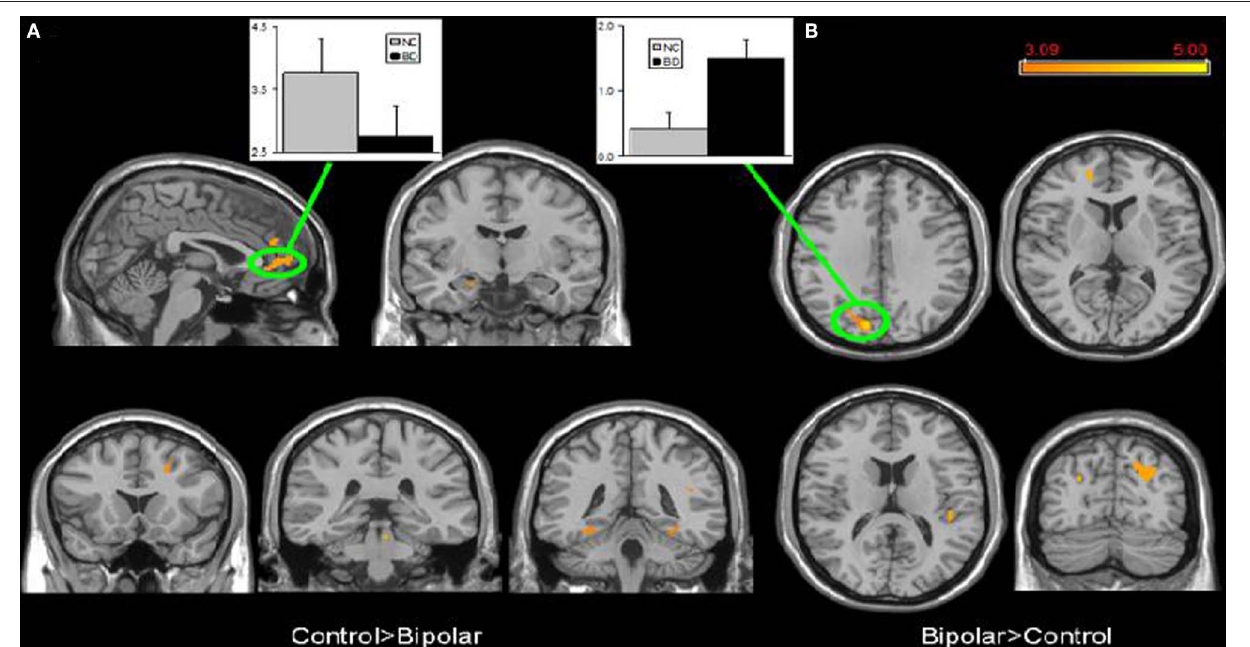
FIGURE 5 | Significant differences in the default mode network spatial extent between normal control and bipolar disorder subjects in whole brain analysis mapped onto parasagittal, coronal, and axial slices from a single subject’s structural image in Talairach space; (A) Normal control > Bipolar disorder; (B) Bipolar disorder > Normal control. In each panel,